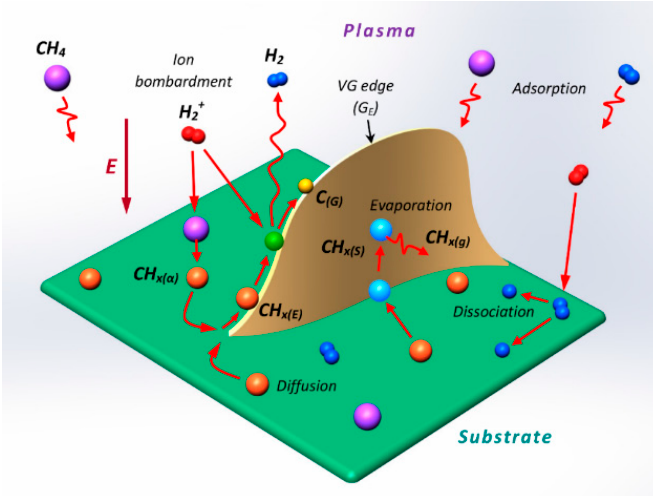
Figure 7. A schematic explanation of the CNW growth model. E: The direction of an electric field; CHx (g) : HC growth species; C (G) : Graphene sheets; H: Atomic hydrogen used as an etchant. CH x( α ) : a-C etched along with H atoms in the form of hydrocarbon (HC); VG edge: Edges of vertically-oriented CNWs. Reproduced with permission from [63]. Copyright Elsevier 2007.